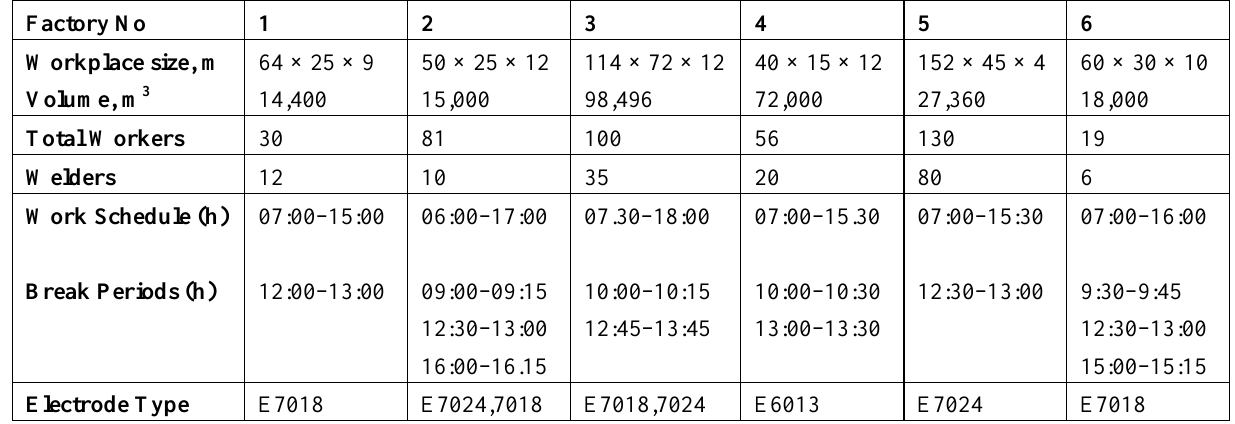
Table 1 . Sizes of Work Places, Number of Workers and Electrode